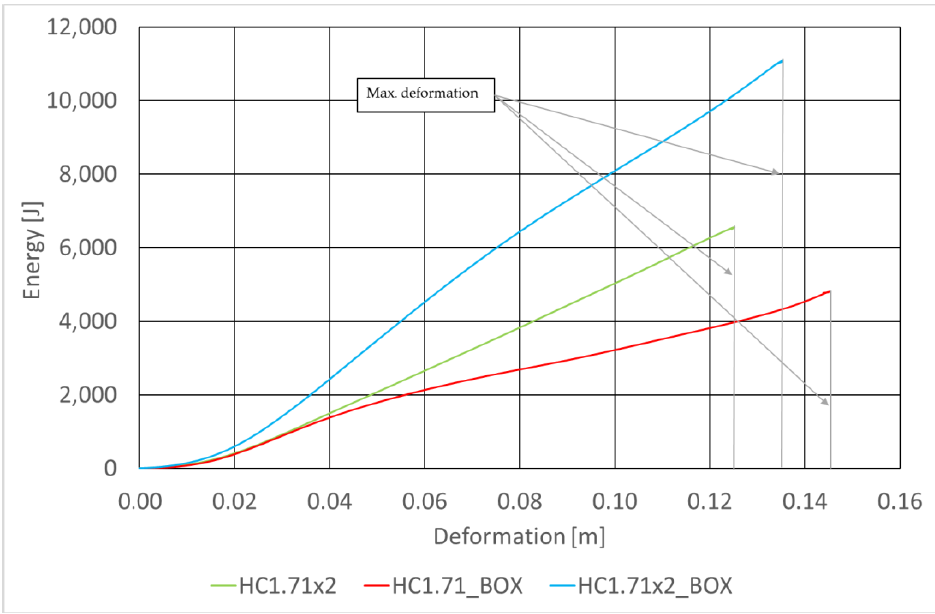
Figure 22. Energy absorbed at the maximum deformation of the energy-absorbing segments.